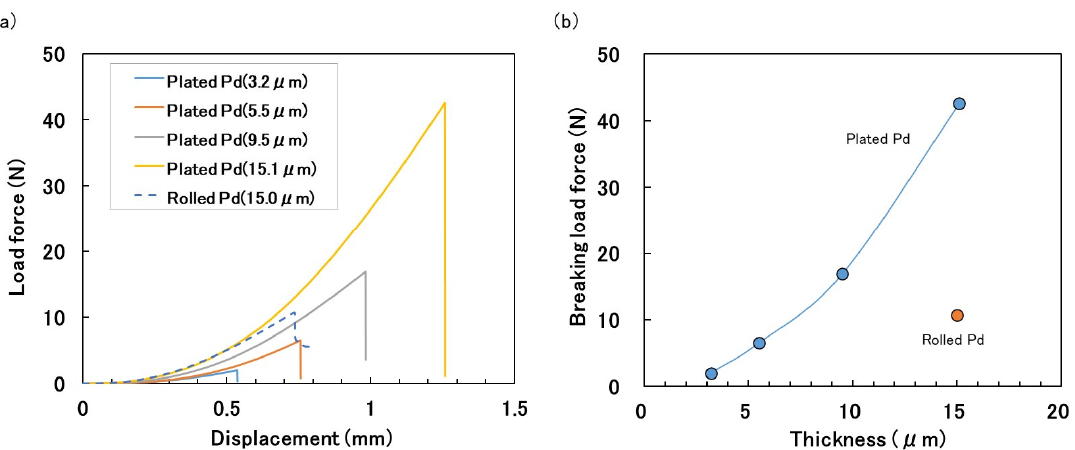
Figure 3. ( a ) Plots of load force (N) vs. displacement (mm) for the as-plated Pd films (3.2–15.1 μ m thickness) and as-rolled one (15 μ m thickness). ( b ) Plots of breaking load force (in N) vs. thickness thickness) and as-rolled one (15 µ m thickness). ( b ) Plots of breaking load force (in N) vs. thickness ( μ m) of the plated and rolled pure Pd films. ( µ m) of the plated and rolled pure Pd